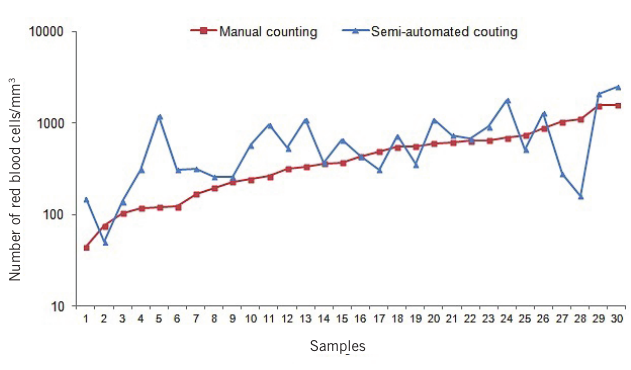
figuRE 2 − Comparison between manual (Fuchs-Rosenthal chamber) and semi-